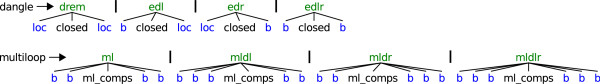
Grammar MicroState extends the rules of grammars NoDangle or OverDangle for the non-terminal symbols "dangle" and "multiloop". Instead of just one way, we now have four alternatives to dangle bases onto a closed substructure: Both neighboring bases do not dangle (drem and ml), only the left neighbored base dangles onto the stack (edl and mldl), only the right one (edr and mldr), or both ones (edlr and mldlr).